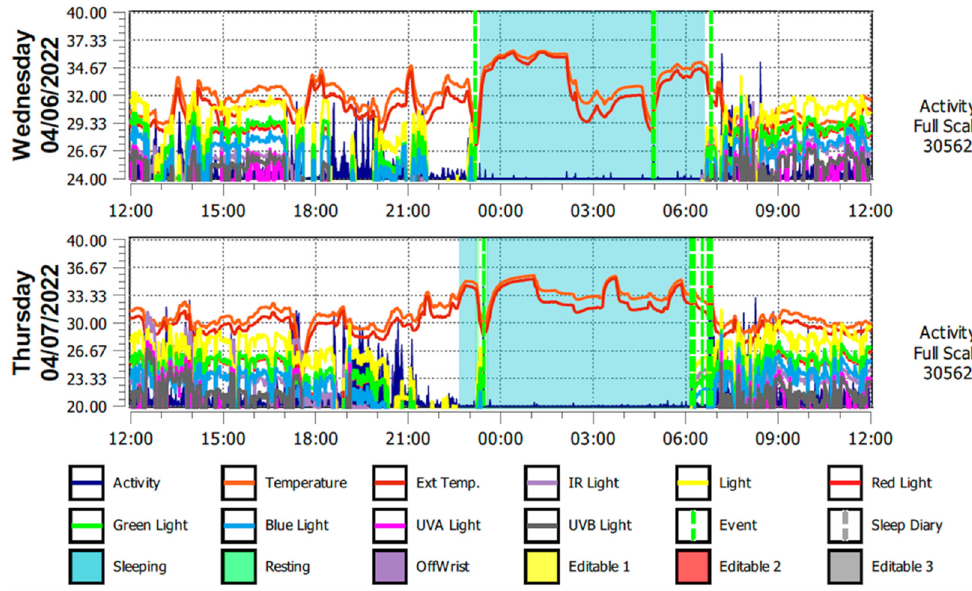
Figure 2. Actogram (example from the authors’ study exploring ActTrust 2 device and ActStudio software).